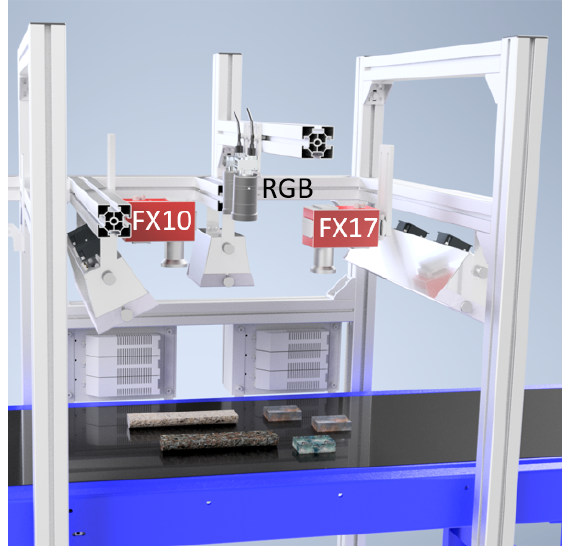
Figure 1. Schematic view on the set-up used for data acquisition, consisting of a multi-sensor system, which is placed above a conveyor belt. The belt has a width of 500